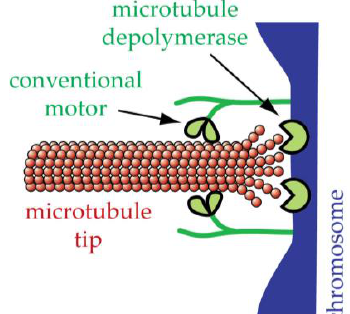
Figure 6. Model for kinetochore-microtubule tip-coupling based on conventional motor proteins and microtubule-regulators. Conventional ATP-powered, minus end-directed motor enzymes anchored